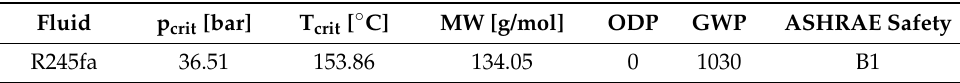
Table 1. R245fa main characteristics. Data from